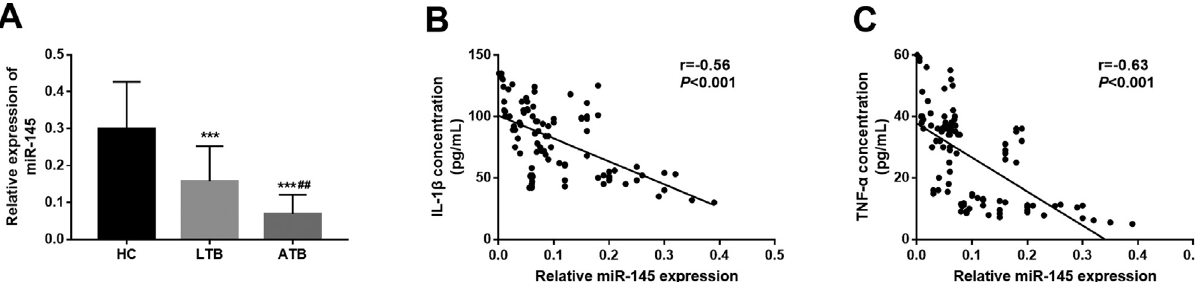
Figure1 -SerumexpressionofmiR-145anditscorrelationwithserumlevelsofinflammatorycytokines.A.SerumexpressionofmiR-145wasdecreased in the TB patients compared with the healthy controls, and the lowest expression of miR-145 was observed in the ATB patients. B and C. Serum expres- sion of miR-145 was negatively correlated with the concentrations of IL-1 (cid:2) (B; r = -0.56, P < 0.001) and TNF- (cid:3) (C; r = -0.63, P < 0.001). HC, healthy control; LTB, latent tuberculosis; ATB, active tuberculosis; ** P < 0.01, *** P < 0.001 vs. HC; ## P < 0.01 vs. LTB.